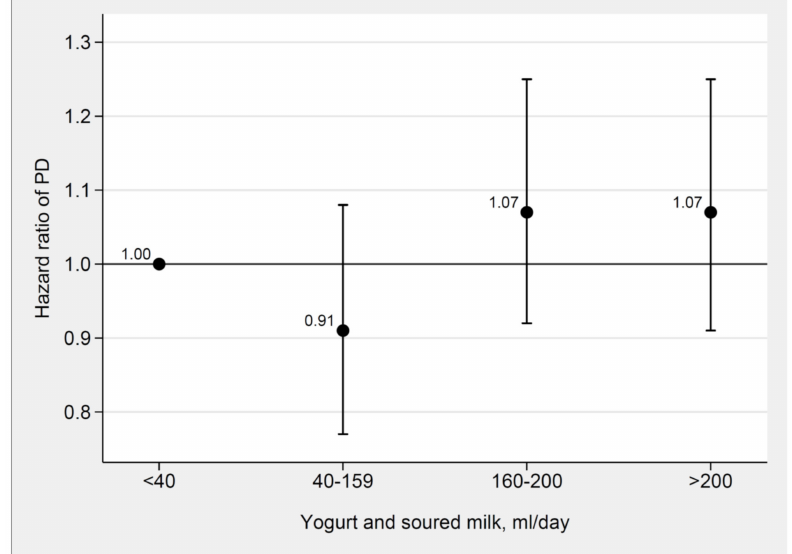
Figure 2. Adjusted hazard ratios for fermented milk intake and incident Parkinson’s disease in the whole study population. Hazard ratios of the associations between yogurt and soured milk intake and incident Parkinson’s disease adjusted for sex, smoking, education, alcohol, co ff ee, total energy intake, body mass index, physical activity, living alone, fruit and vegetables, vitamin and mineral supplements, and milk intake using Cox proportional hazard regression with age as time scale in the whole study population (the Swedish Mammography Cohort and the Cohort of Swedish